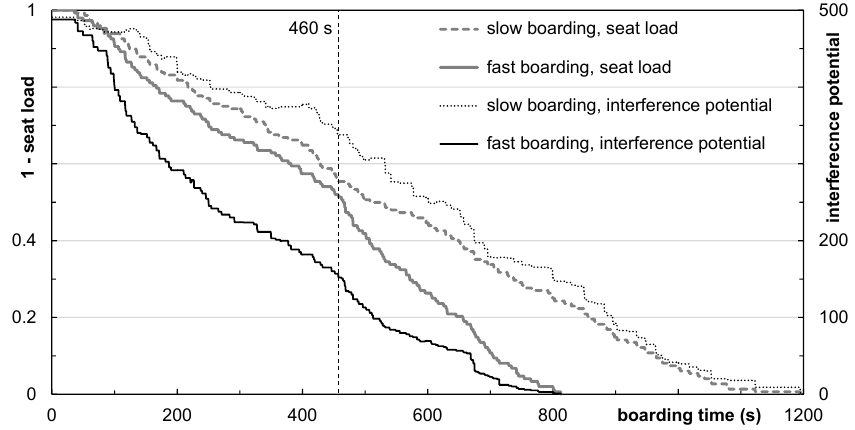
Figure 18. Different progress indicators for both slow and fast boarding: seat load and interference potential.